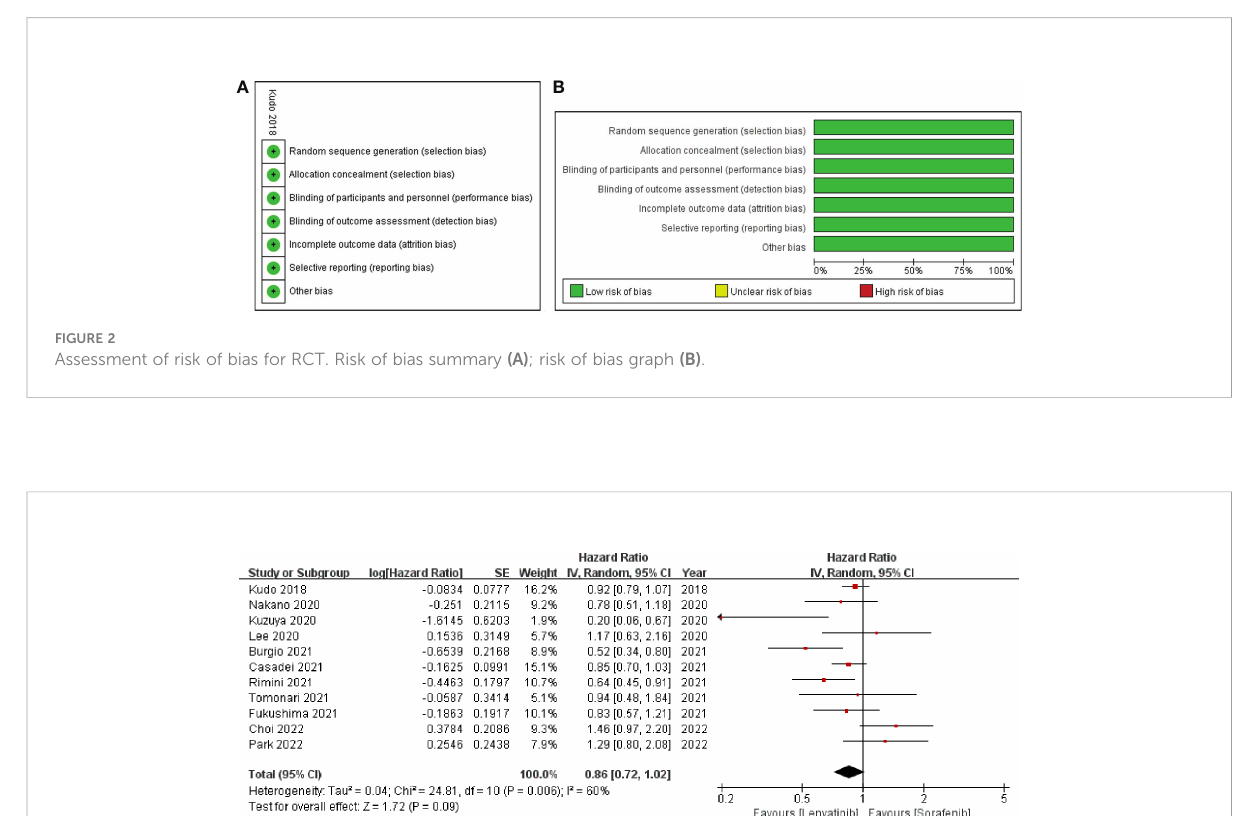
FIGURE 3 Forest plot on OS. OS, overall